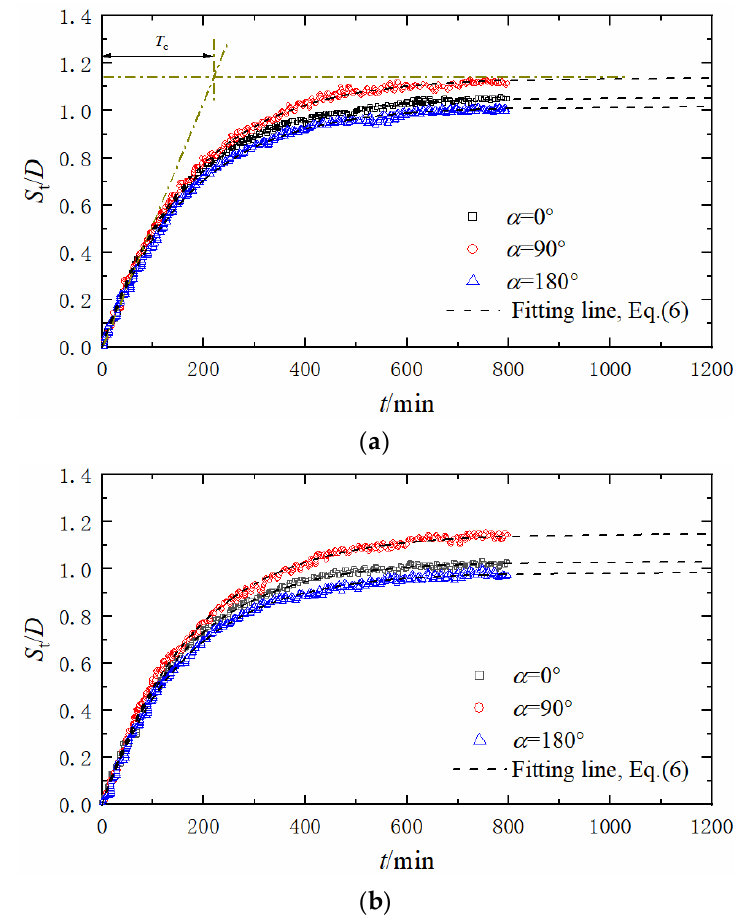
Figure 4. Scour evolution curves for: ( a ) Case R4; ( b ) Case R15.